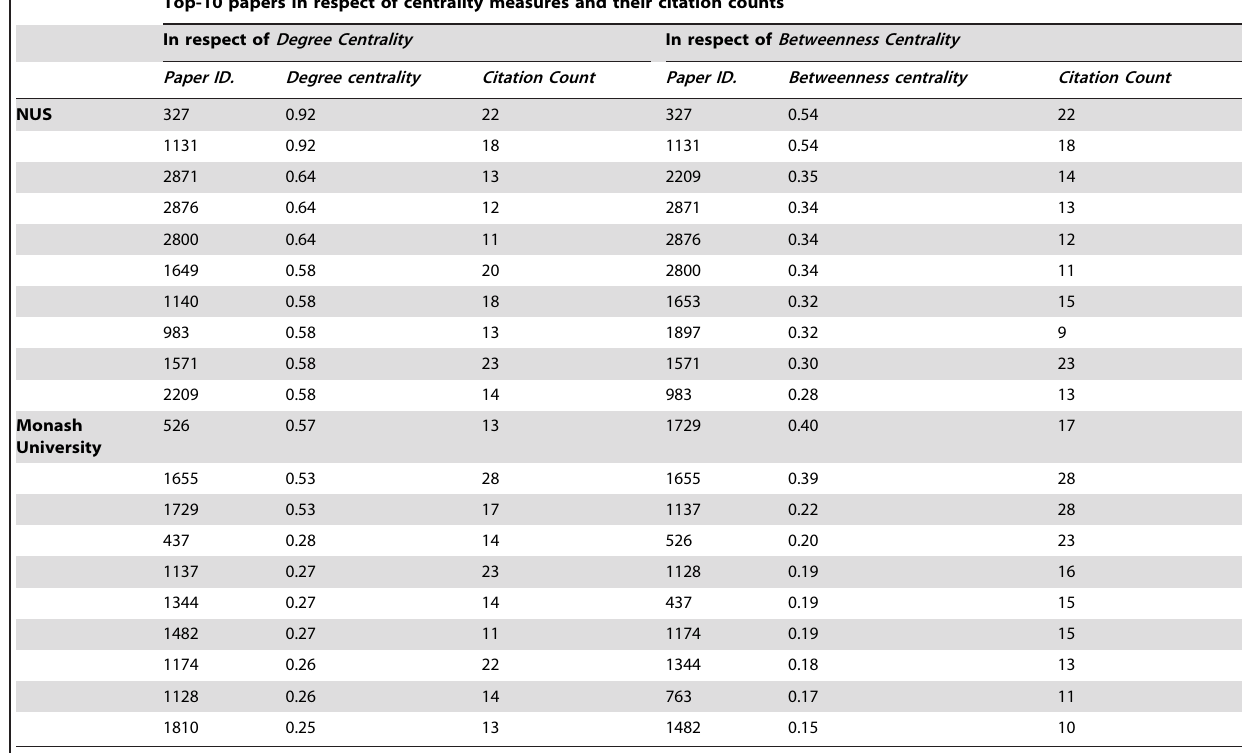
Table 4. Top-10 papers (in respect of average of degree centrality and betweenness centrality values of co-authors) and their corresponding citation counts.